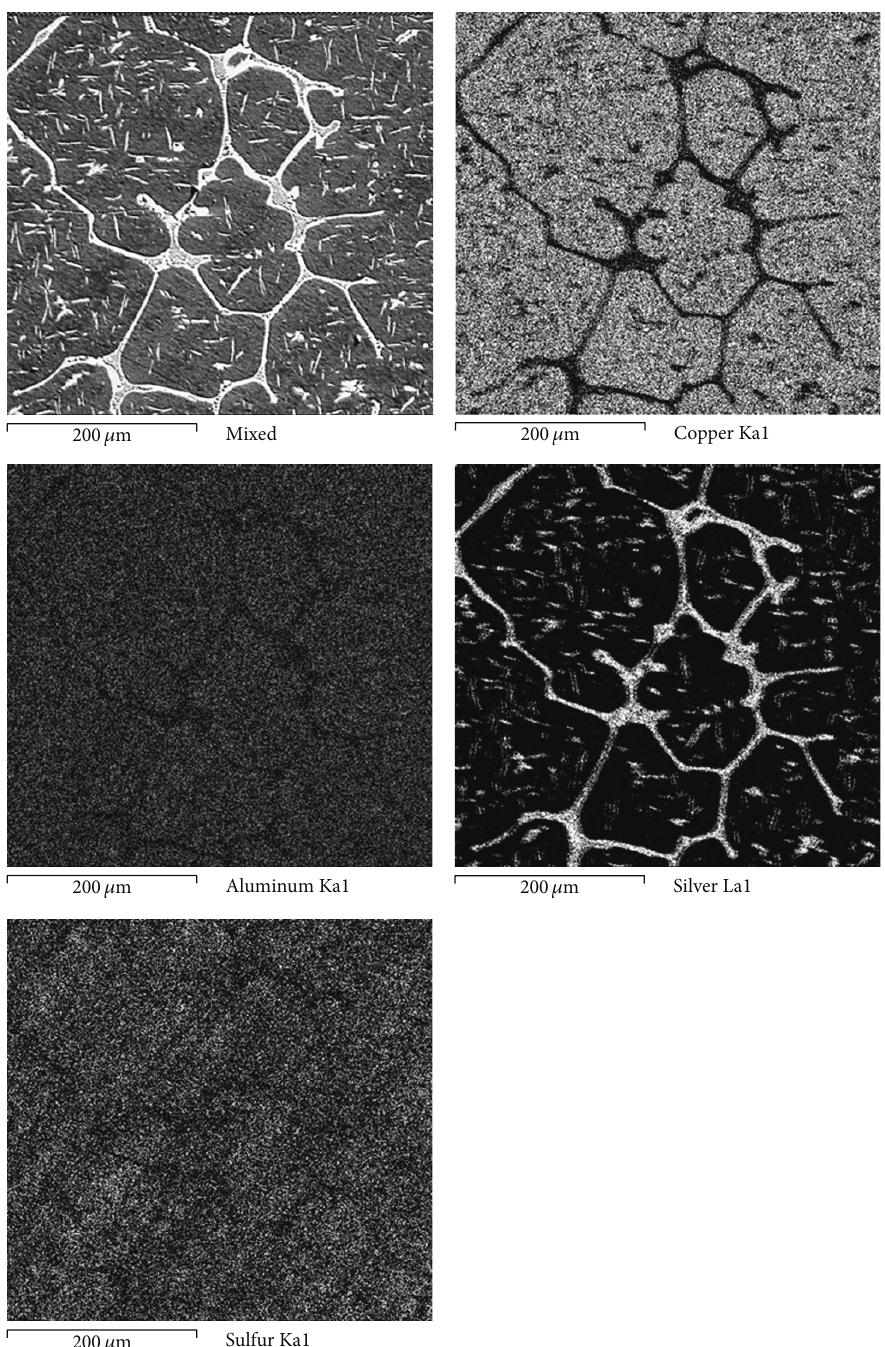
Figure 11: Superficial aspect of the Cu10Al-15Ag alloy and elements mapping after the corrosion test in artificial saliva at 37 ∘ C for 48 hours.